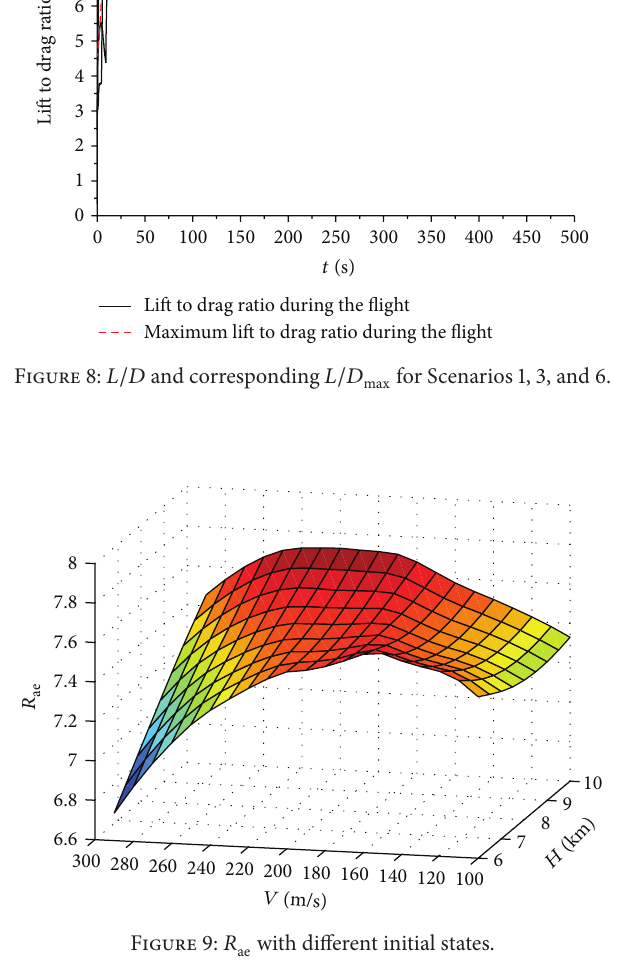
Figure 7: Velocities for Scenarios 1, 3, and 6.